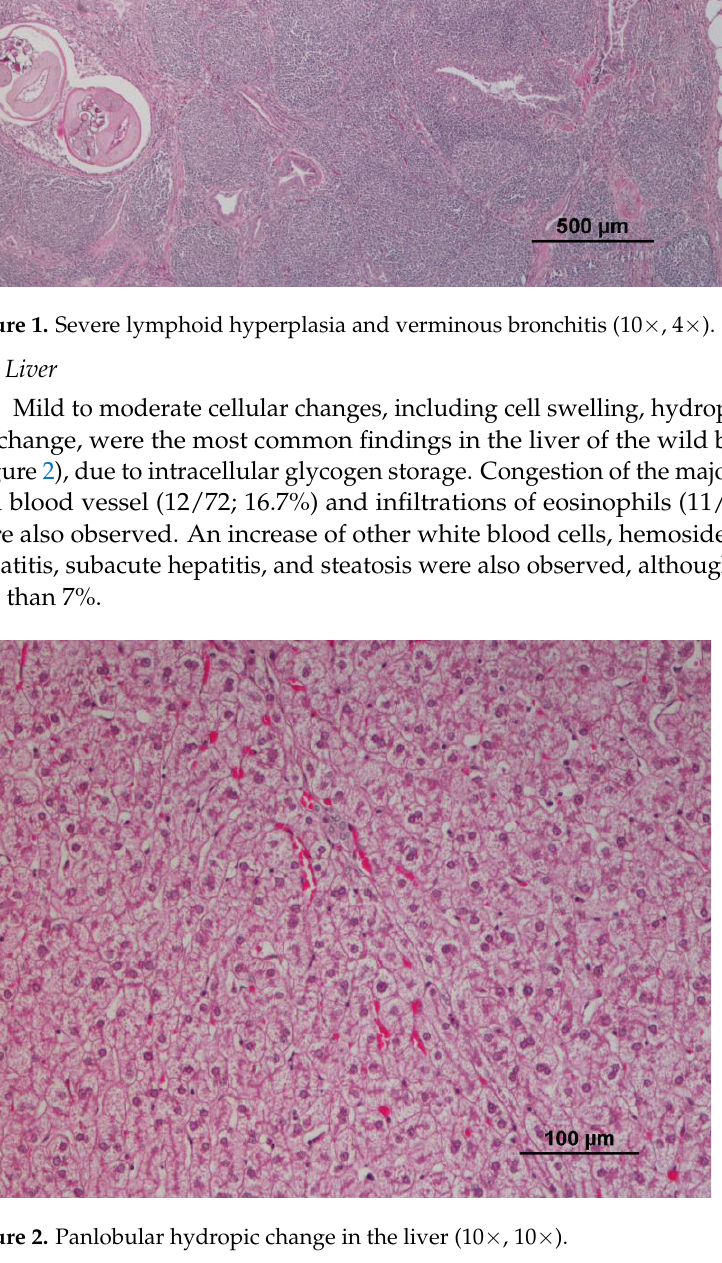
Figure 2. Panlobular hydropic change in the liver (10×, 10×).